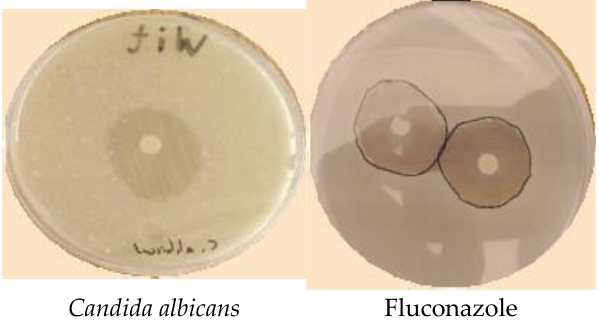
Figure 4. photographs showing zones of inhibition of EOW along with Fluconazole against fungi. Figure 4. Photographs showing zones of inhibition of EOW along with Fluconazole against